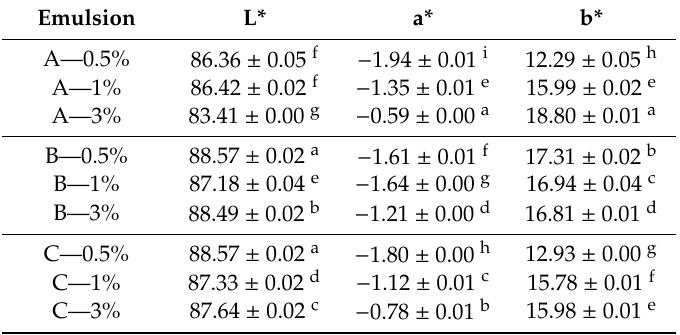
Table 6. Color values of emulsions prepared with various content of FOCE powders.